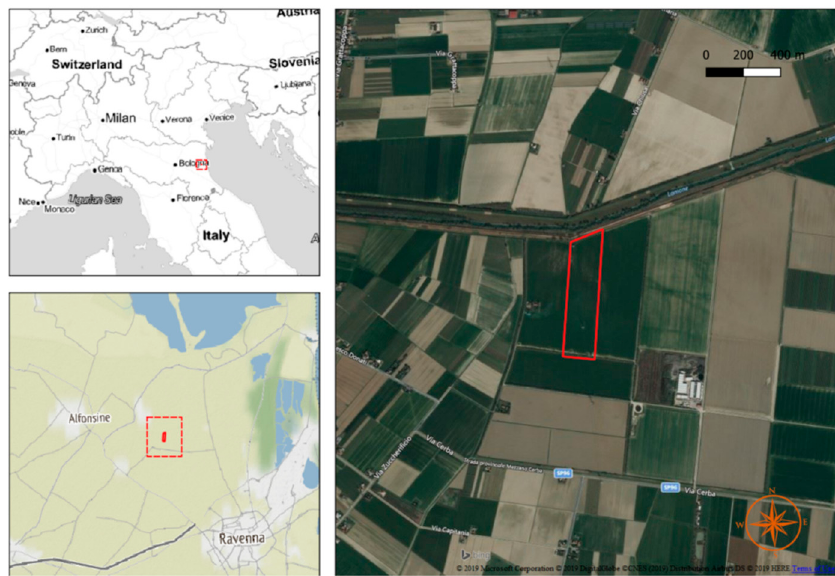
Figure 1. Study area location map. Detail framed by red trapezium, whose coordinates are: